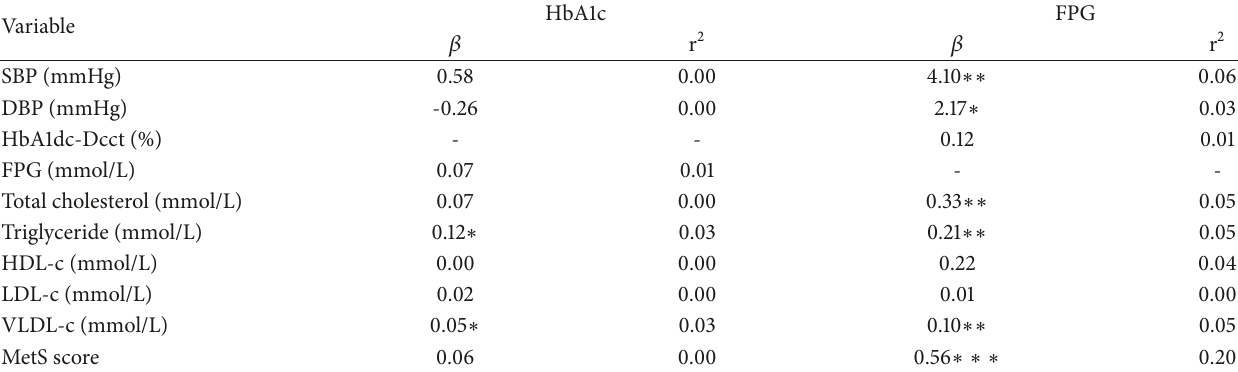
Table 4: Linear regression analysis between HbA1c, FPG, and selected indicators of cardiometabolic risk factors.